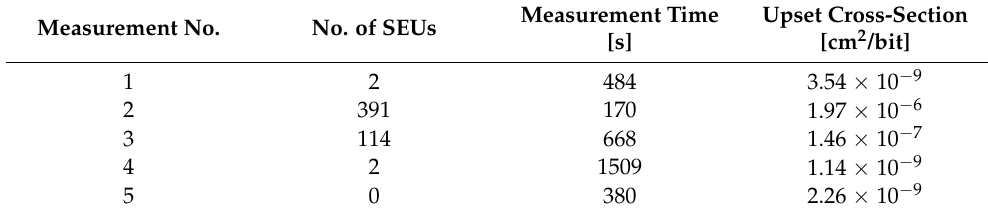
Table 6. SEU results under Xe irradiation. Measurement